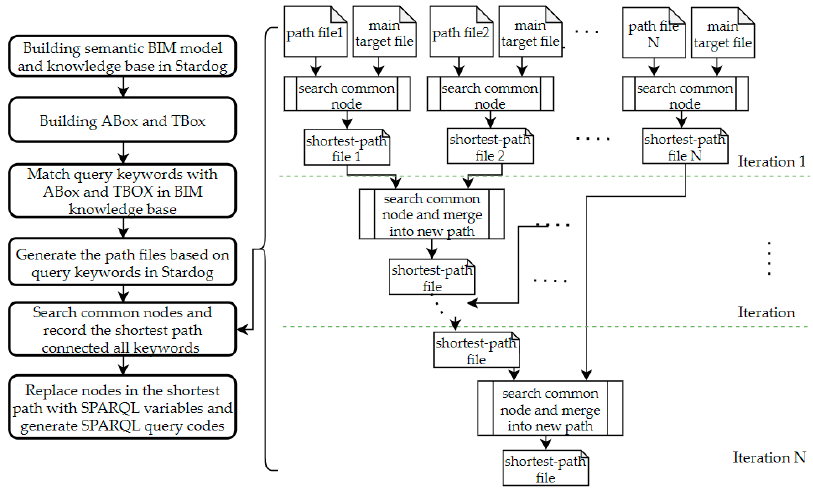
Figure 3. The processing flow of the proposed approach.